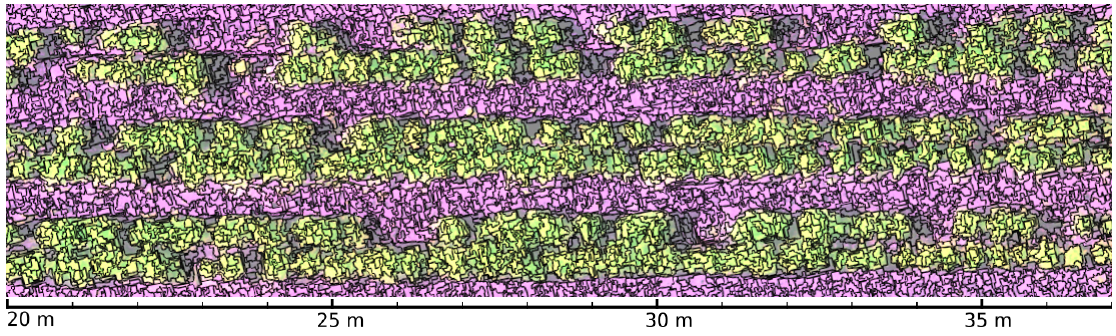
Figure 3. Large scale mean shift segmentation (LSMSS) segmentation of a multispectral crop’s image composed by the green (G), red (R), red edge (RE), and near infrared (NIR)